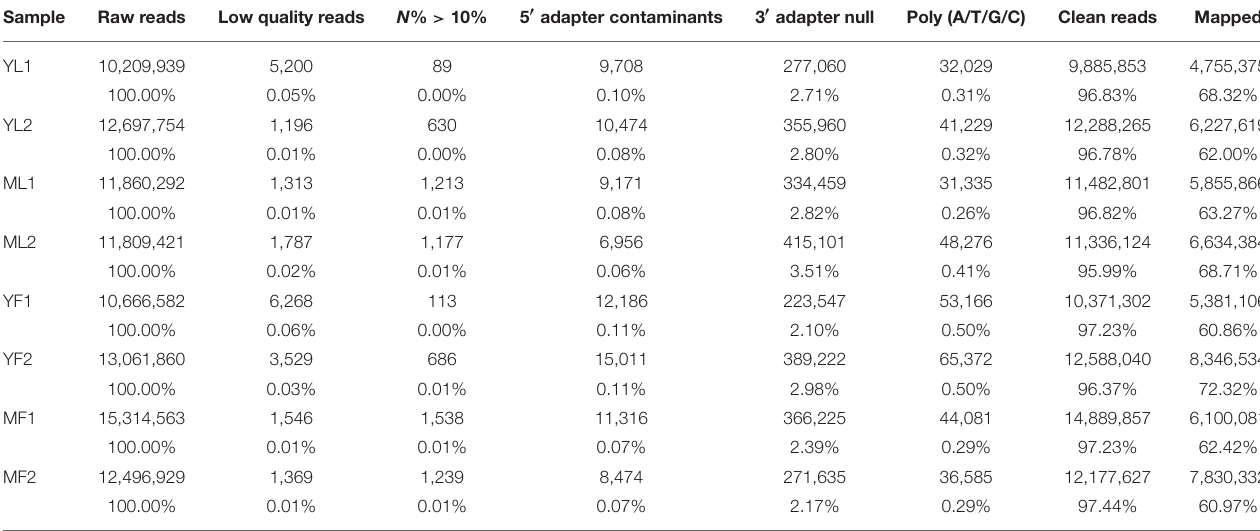
TABLE 1 | Statistical summary of the data generated by high-throughput sequencing in Eucommia ulmoides.